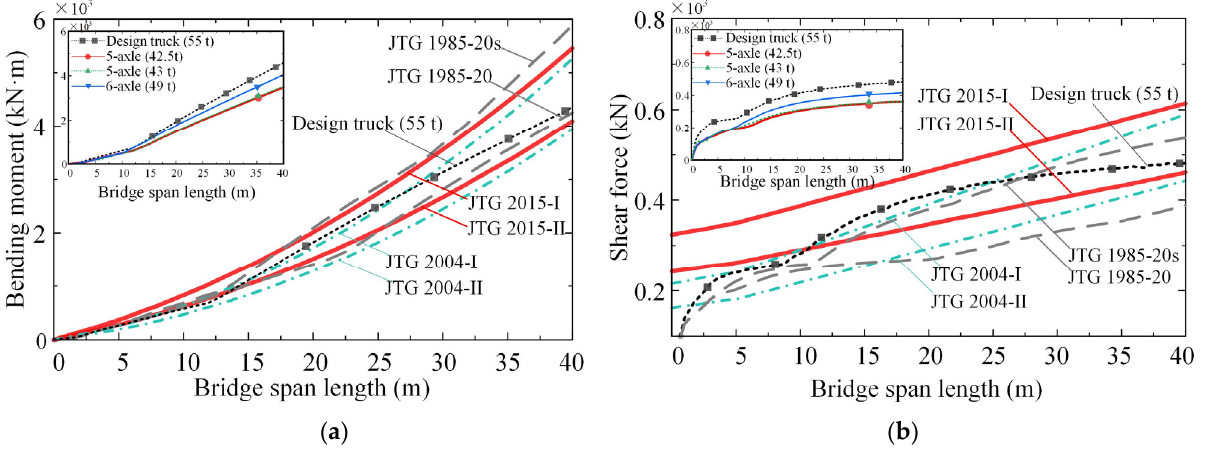
Figure 6. Load effects of simply supported bridges due to design vehicle loads: ( a ) bending moment; ( b ) shear